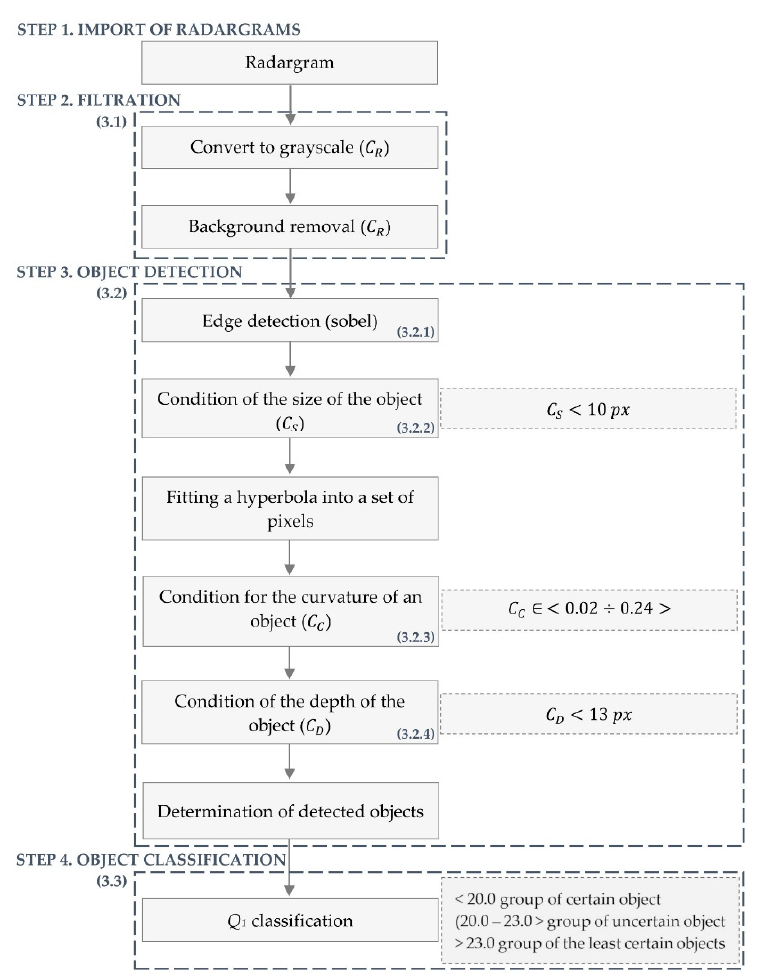
Figure 5. Location of selected candidate points in reference to the benchmark data obtained from the NGCR.